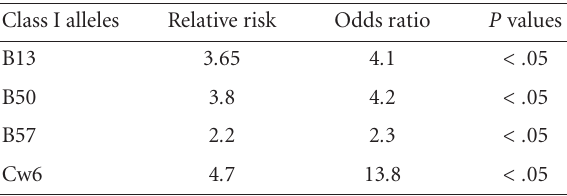
Table 2. Relative risk, odd value, and P value of MHC alleles in patients with